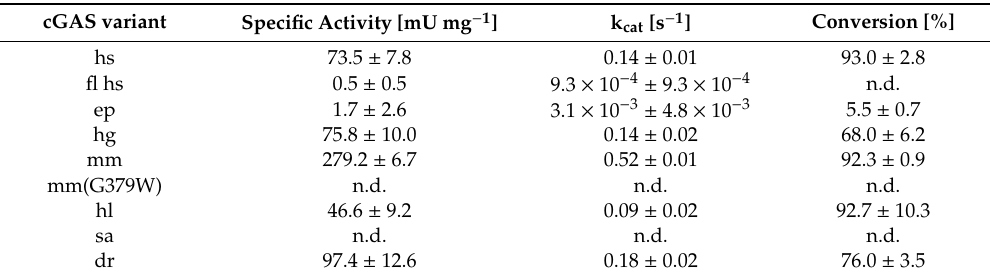
Table A3. Enzyme kinetic parameters of cGAS variants. cGAS enzyme activity was calculated based on cGAMP formation. Conversion is shown for ATP. Data are represented as mean ± SD of biological